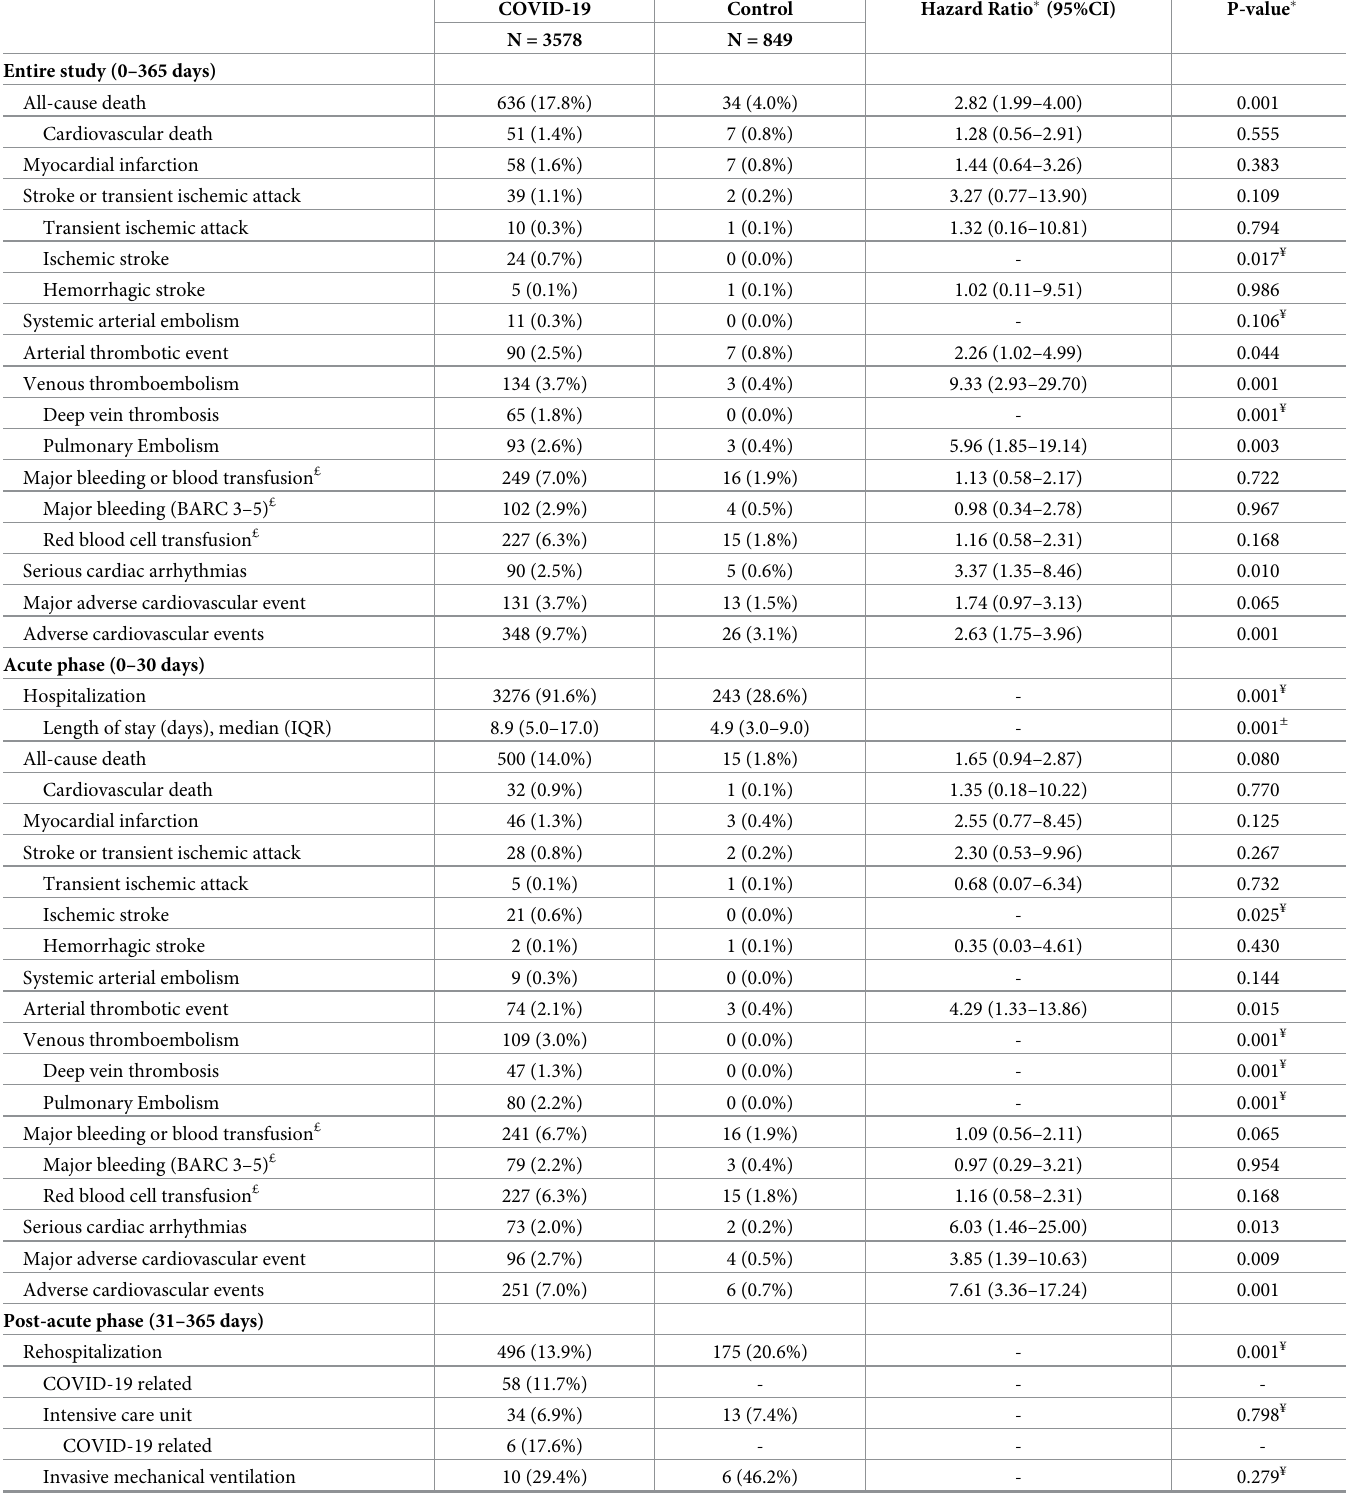
Table 3. Clinical